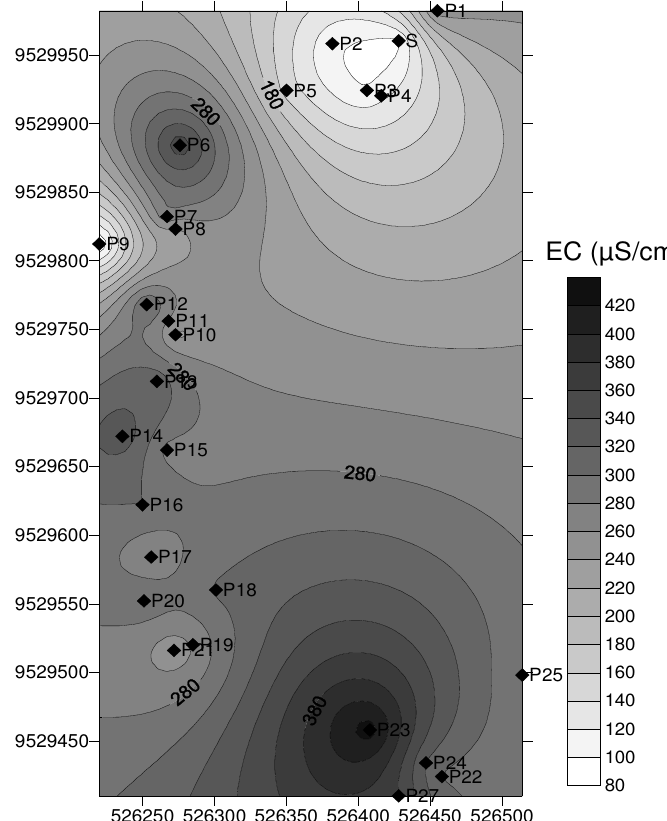
Figure 1. Contour map of EC (in µS/cm) in the wells water and spring